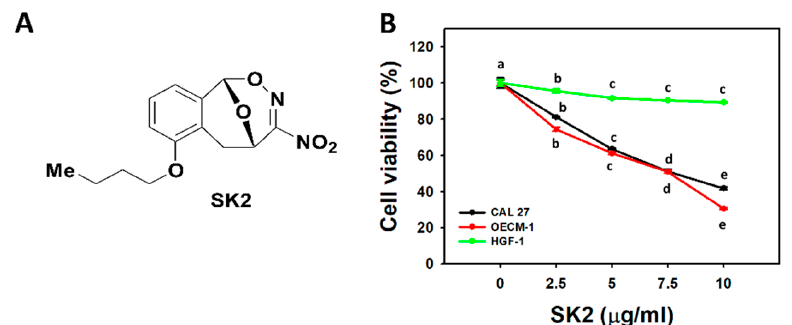
Figure 1. Structure and cell viability effect of SK2. ( A ) Structures of SK2. IUPAC name: 6- n -butoxy- 10-nitro-12,13-dioxa-11-azatricyclo[7.3.1.0 2,7 ]trideca-2,4,6,10-tetraene. ( B ) Cell viability. Oral cancer cells (CAL 27 and OECM-1) and non-malignant oral cells (HGF-1) were exposed to SK2 (0 (0.1% dimethyl sulfoxide (DMSO)), 2.5, 5, 7.5, and 10 µg/mL; 0, 8.56, 17.11, 25.68, and 34.23 µM) for 24 h, and their viabilities were assessed by MTS assays. Data (means ± SDs; n = 3) without overlapping characters differed significantly ( p < 0.0001). For an example of CAL 27 and OECM-1 cells, different concentrations showing different characters indicate significantly different results. For HGF-1 cells, for SK2 at 0, 2.5, and 5 µg/mL, “a, b, and c” indicate significant differences. For HGF-1 cells, for SK2 at 5, 7.5, and 10 µg/mL, the same letter “c” indicates non-significant differences because the results overlapped.